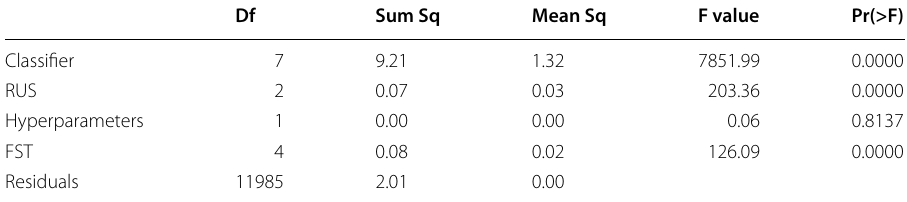
Table 38 ANOVA for classifier, RUS, hperparameters and FST as factors of performance in terms of AUPRC Df